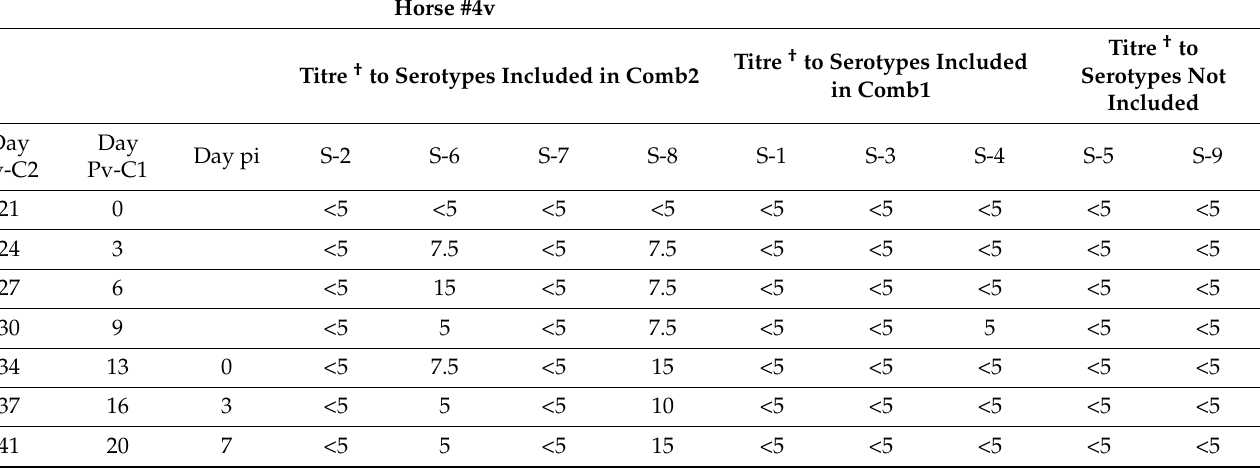
Table 7. Detection of serotype-specific antibodies (sero-neutralization test) in the vaccinated horses. Horse #4v Titre † to Serotypes Included in